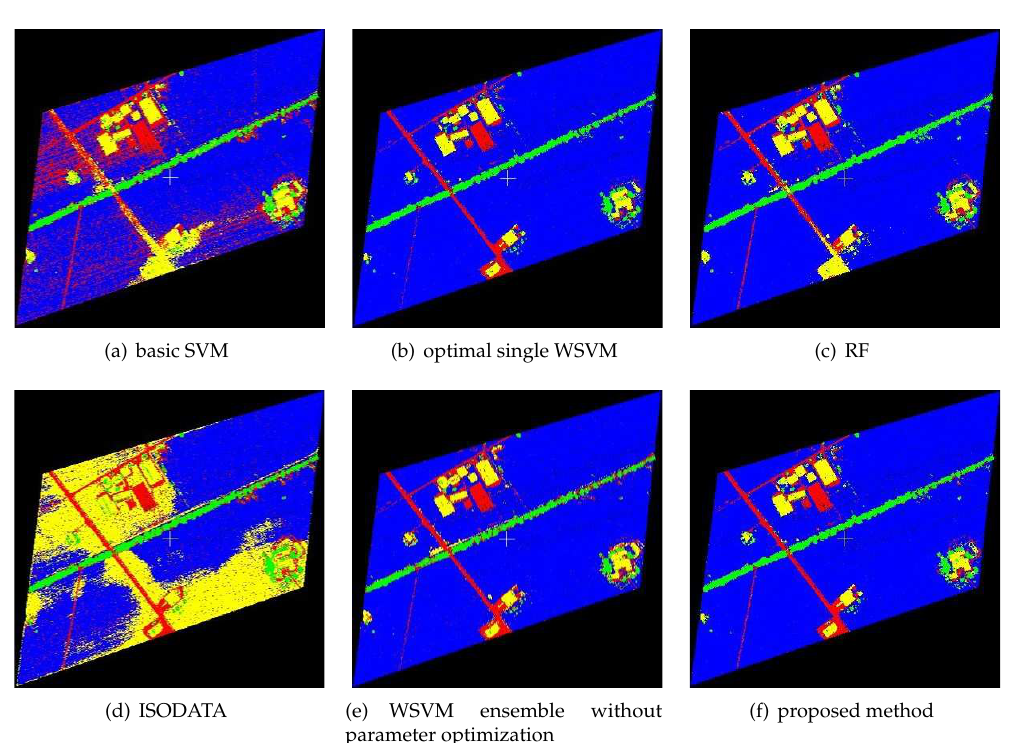
Figure 3. Classification results of Study Area